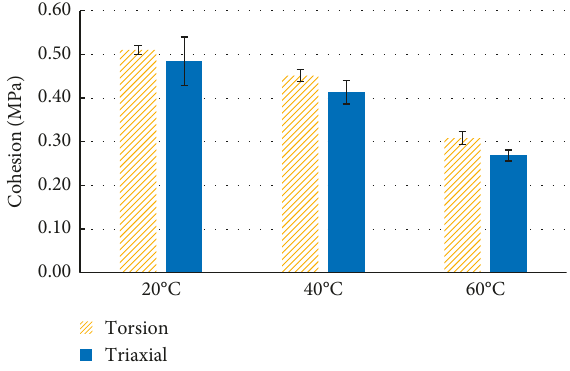
Figure 14: Results of cohesion C at different